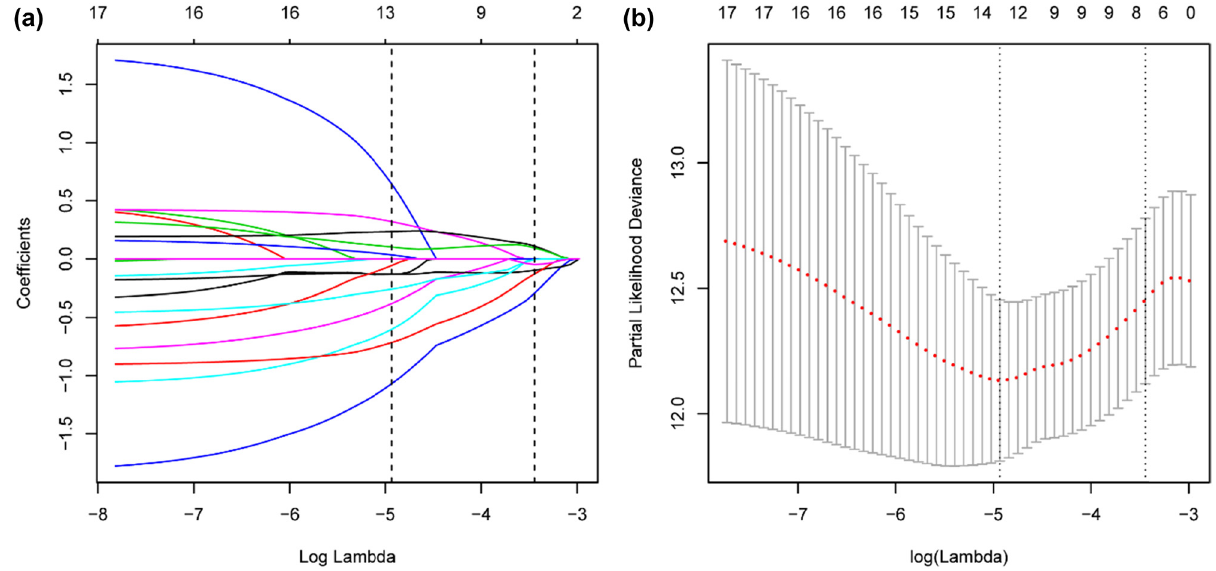
Figure 3: Screening of the core autophagy - related lncRNAs associated with PFI by LASSO COX regression analysis. ( a ) LASSO coe ffi cient of the lncRNAs by 10 - fold cross - validation. ( b ) Partial likelihood deviance with corresponding log ( λ ) values at the minimal deviance.